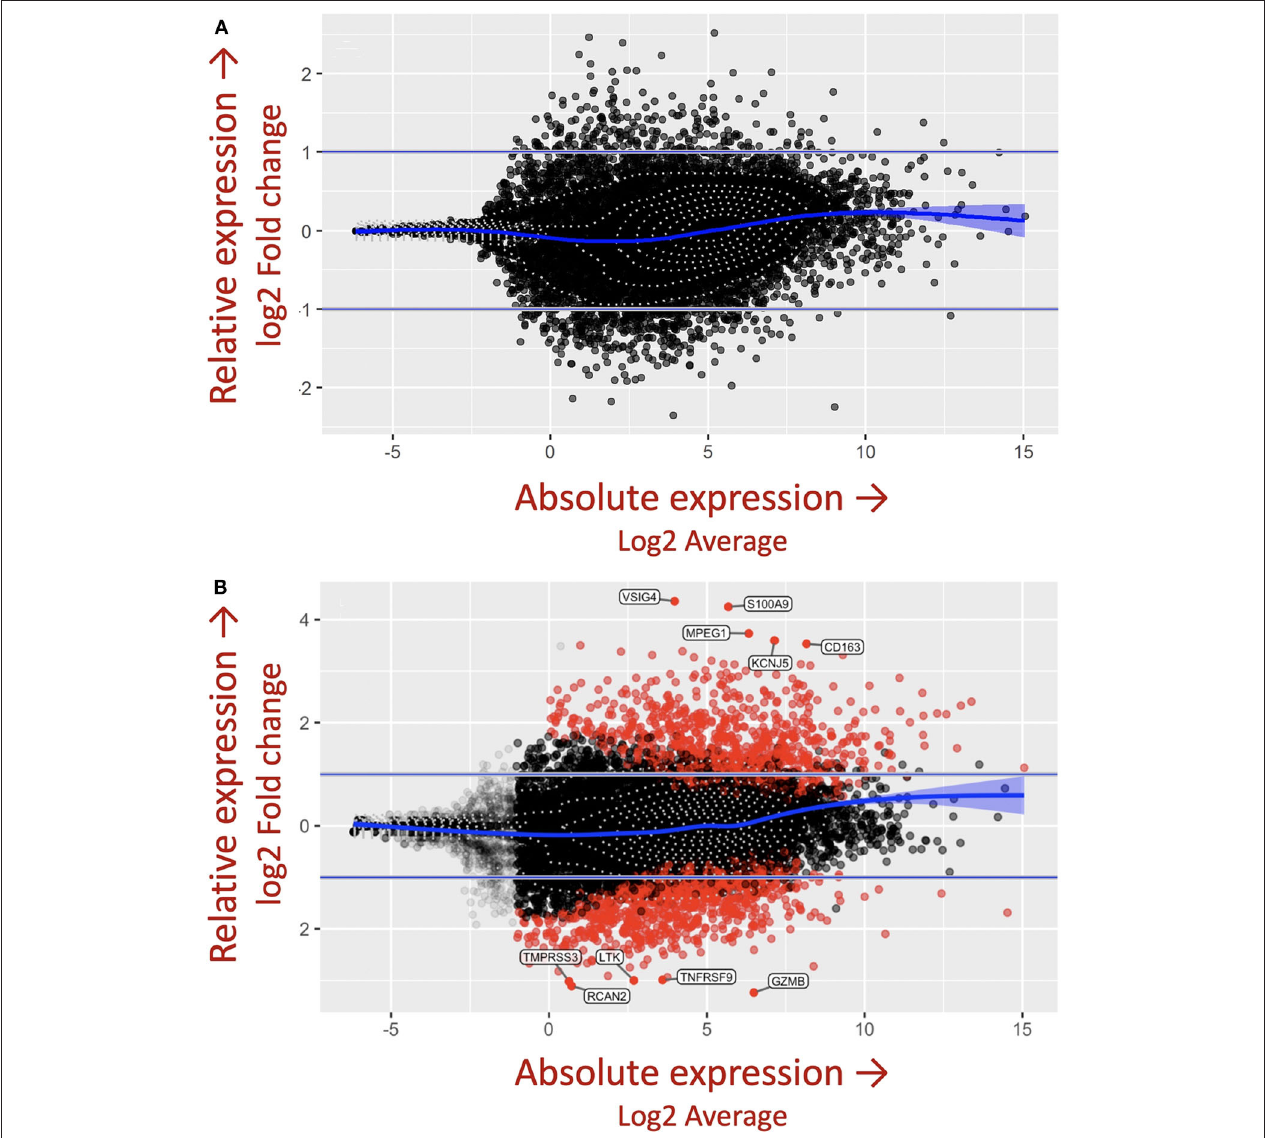
FIGURE 3 | M.tb antigen stimulation induces a unique and divergent transcriptional response in sarcoidosis. Differential gene expression in PBMCs derived from patients with sarcoidosis and healthy control subjects after (A) uncoated and (B) M.tb antigen-coated bead stimulation shown as mva style plots. The x-axis is the log2 average of the gene expression level. All genes with an adjusted P -value of 0.05 and at least a log2-fold change in the magnitude of gene expression (indicated by the two horizontal blue lines) between M.tb antigen and uncoated beads are shaded red.